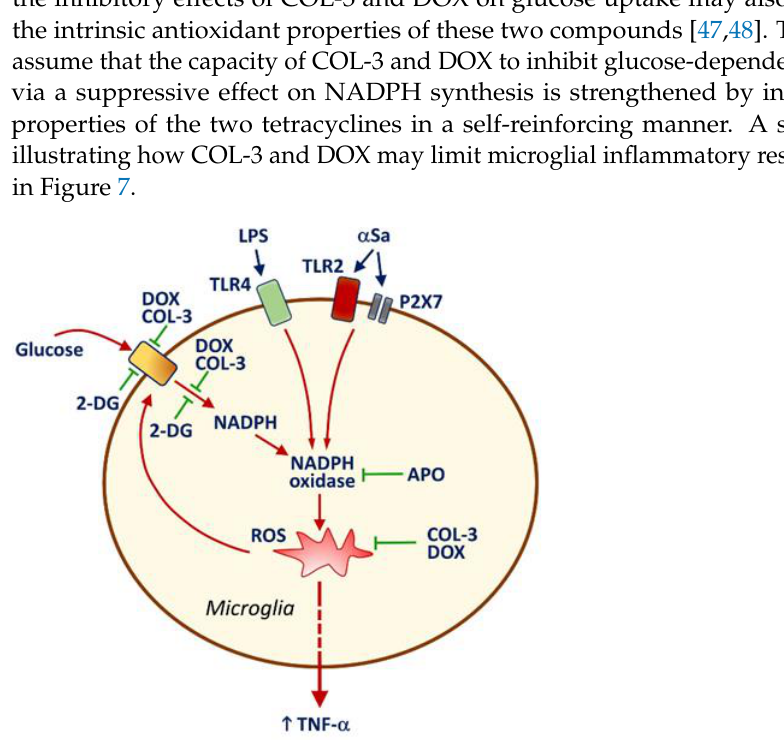
Figure 7. Schematic drawing illustrating how the non-antibiotic tetracycline COL-3 and its parent compound DOX may limit microglial inflammatory responses. LPS and αSa activate TLR4 [33] and TLR2/P2X7 [24,30] signaling pathways, respectively. This results in the activation of the superoxide producing enzyme NADPH oxidase. ROS produced through NADPH oxidase activation stimulate the release of the pro-inflammatory cytokine TNF-α and enhance the uptake of glucose through a mechanism that is preventable by the NADPH oxidase inhibitor APO. The rise in microglial glucose